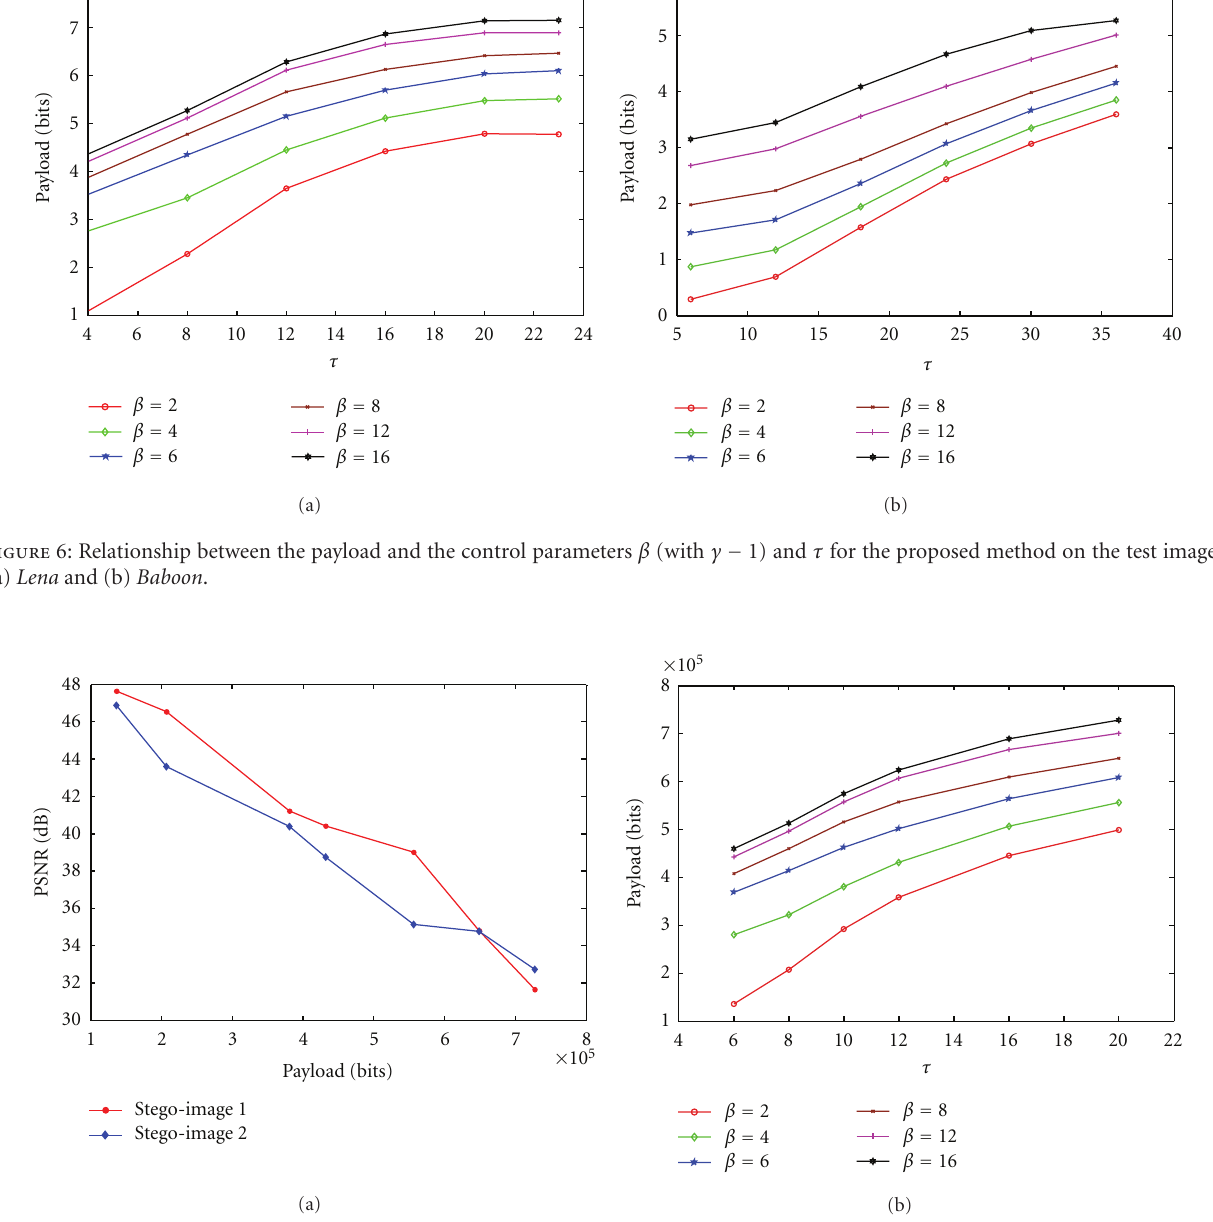
Figure 7: Simulations of the image Ti ff any. (a) Tradeo ff between PSNR and payload and (b) the relationship between the payload and the parameters β (with γ − 1) and τ .